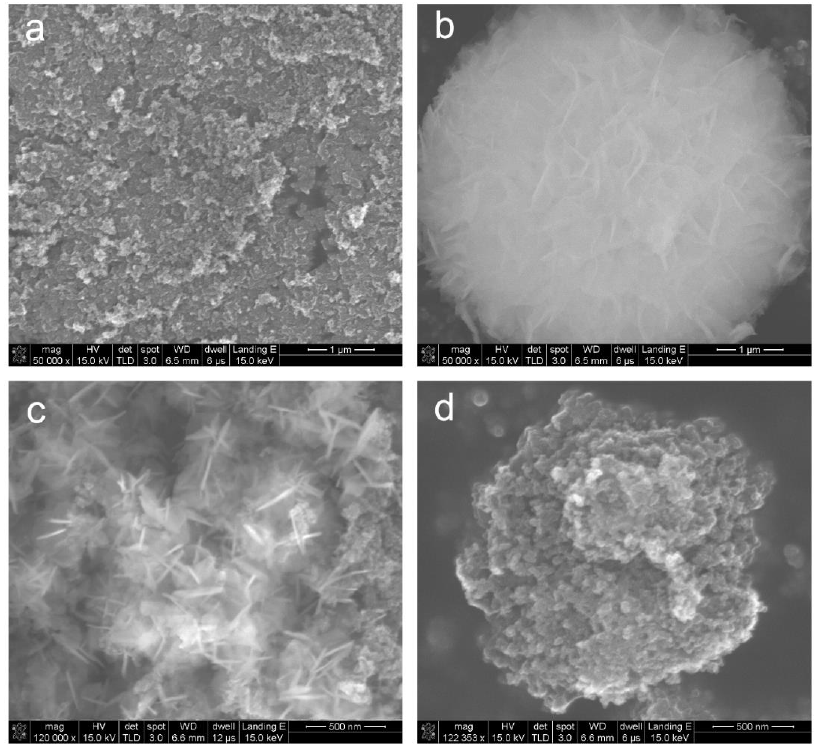
Figure 2. FESEM images of ( a ) BP2000, ( b ) NiFe LDHs, ( c ) NiFe LDHs/CB, and ( d ) NiFe LDHs/CB- TC .